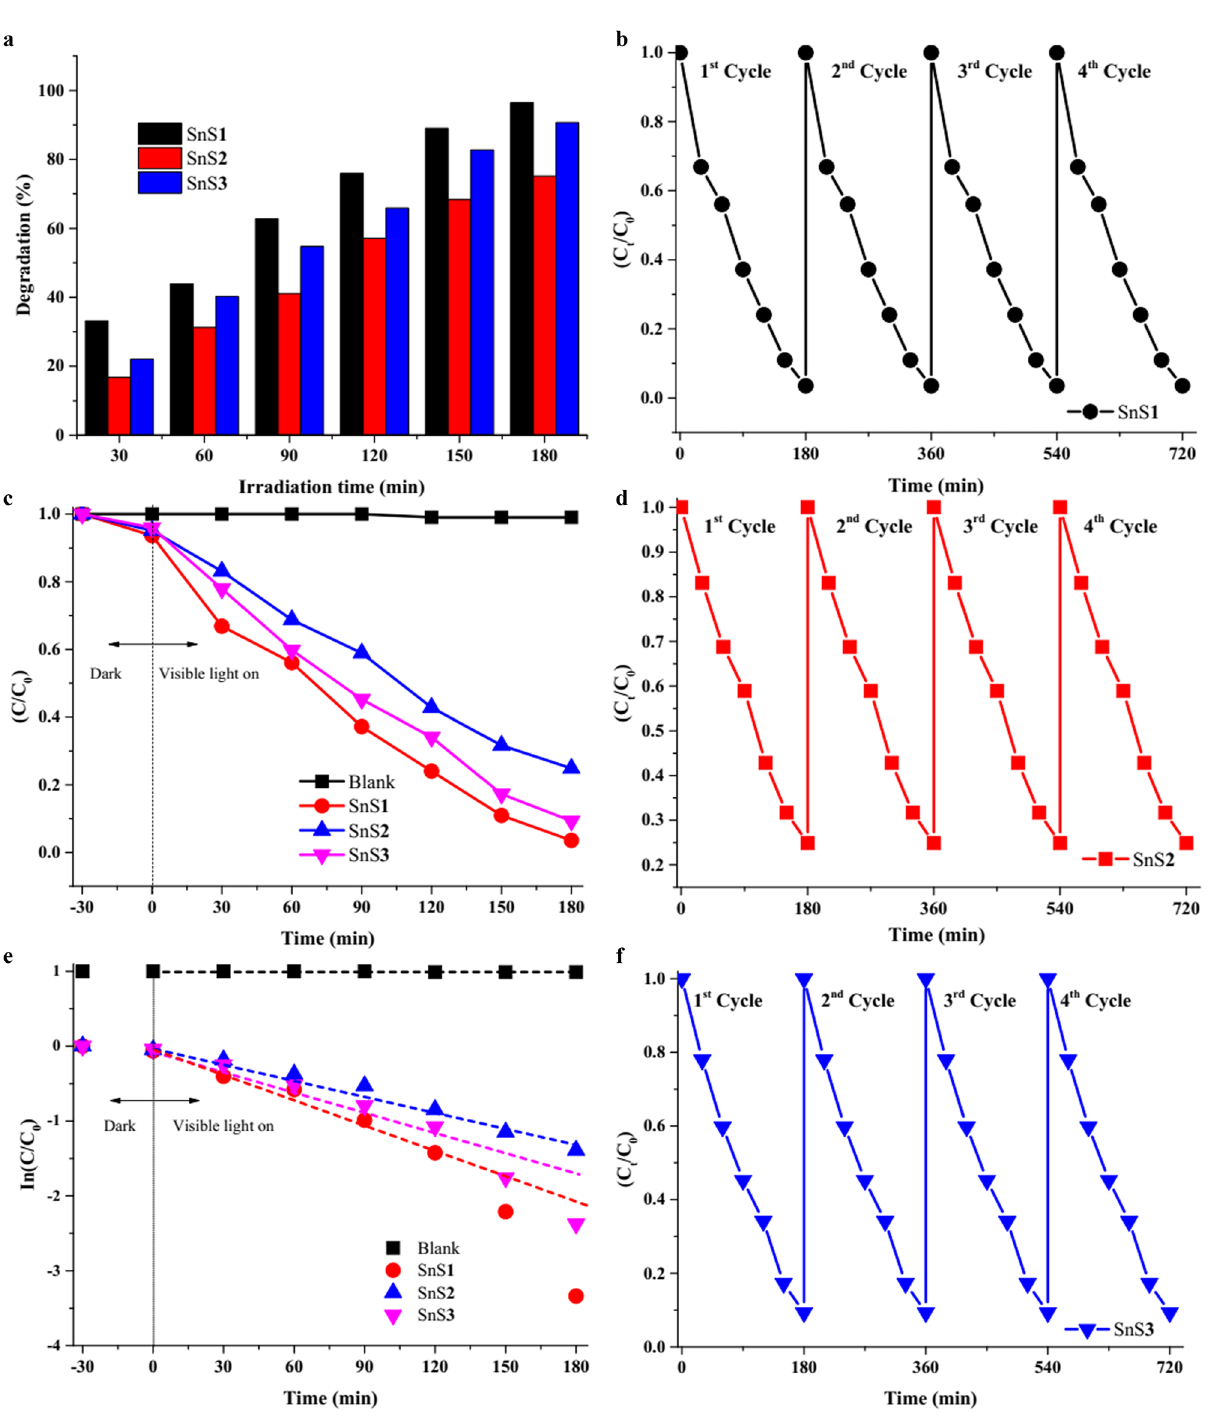
Figure 5: ( a ) Degradation bar chart; ( b ) plot of C t / C 0 versus time; ( c ) kinetic studies; ( d – f ) recycling runs using SnS as photocatalyst for phenol